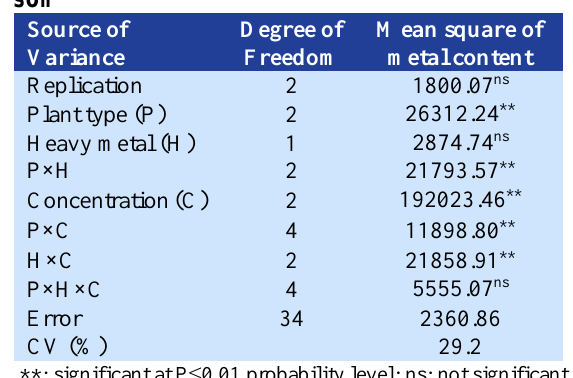
Table2. Analysis of variance for the effect of plant type, type and concentration of heavy metal on phytoremediation of zinc (Zn) and nickel(Ni) from